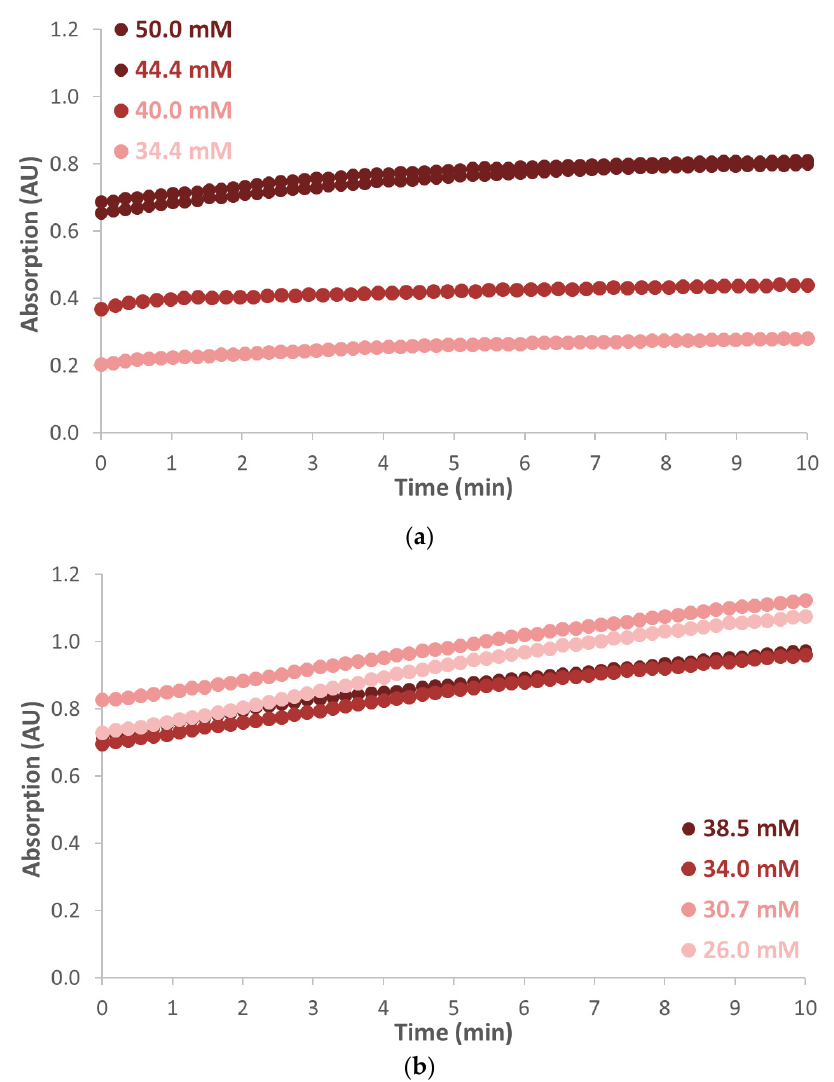
Figure 5. Absorbance measured at 500 nm for ( a ) acetylsalicylic acid dissolved in the Marquis reagent measured in COC chip D and ( b ) lidocaine dissolved in the Marquis reagent measured in COC chip A.